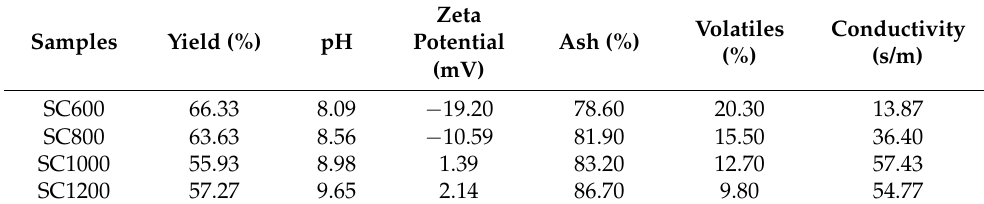
Table 1. Physical parameters of SC samples.